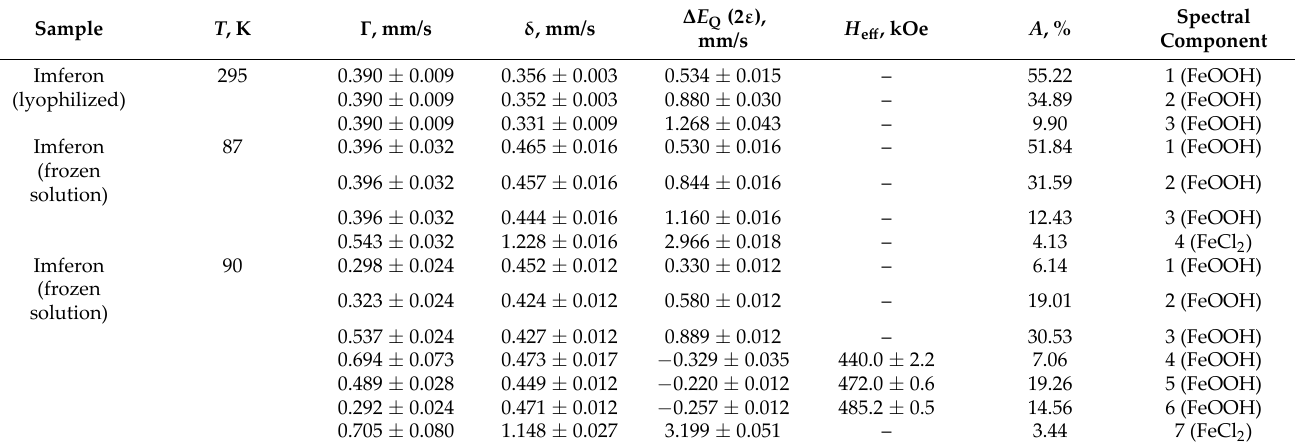
Table 1. Mössbauer parameters for the spectral components of Imferon samples shown in Figure